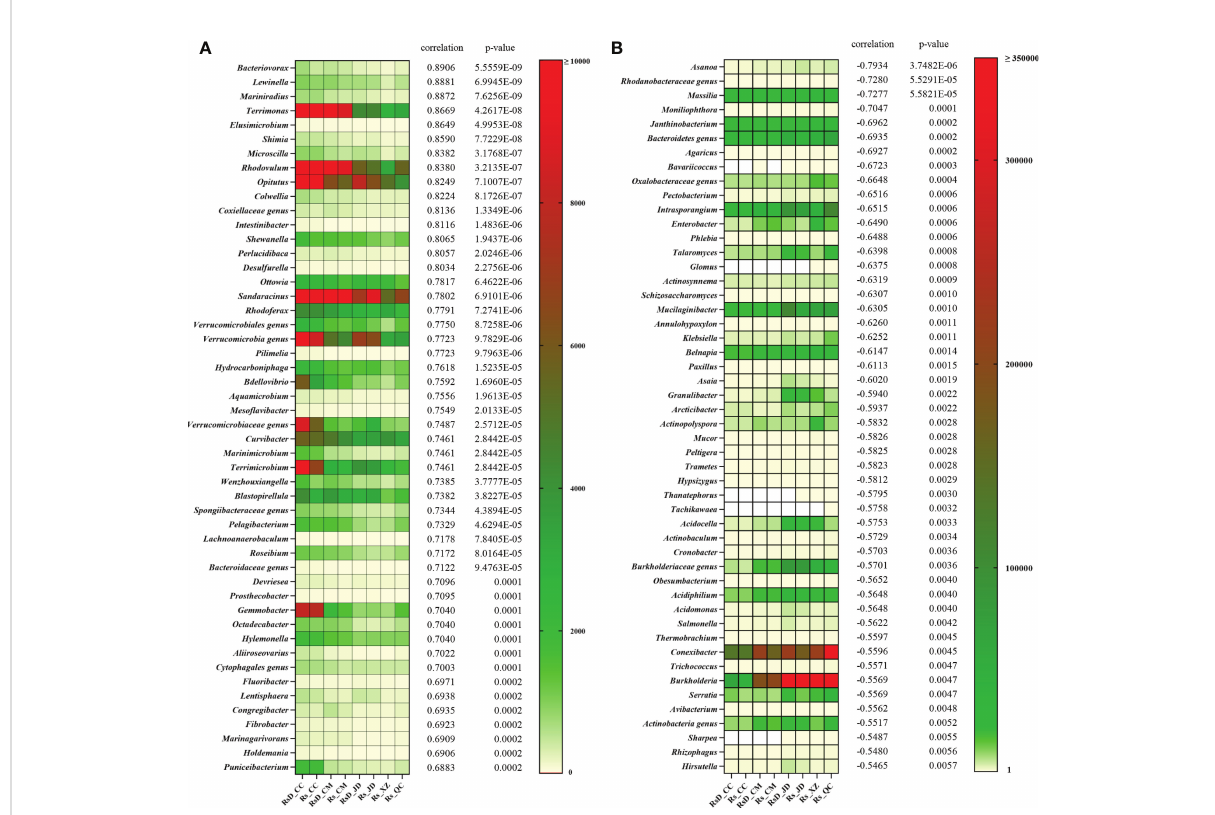
FIGURE 3 Top 50 rhizospheric genera correlations with relative lesion area. (A) Positive correlation and (B) negative